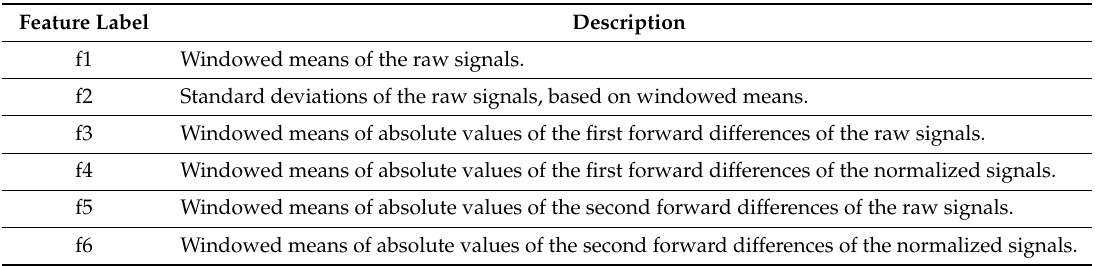
Table 6. Extracted features of raw physiological signals described by Picard et al. [51]. Feature Label Description